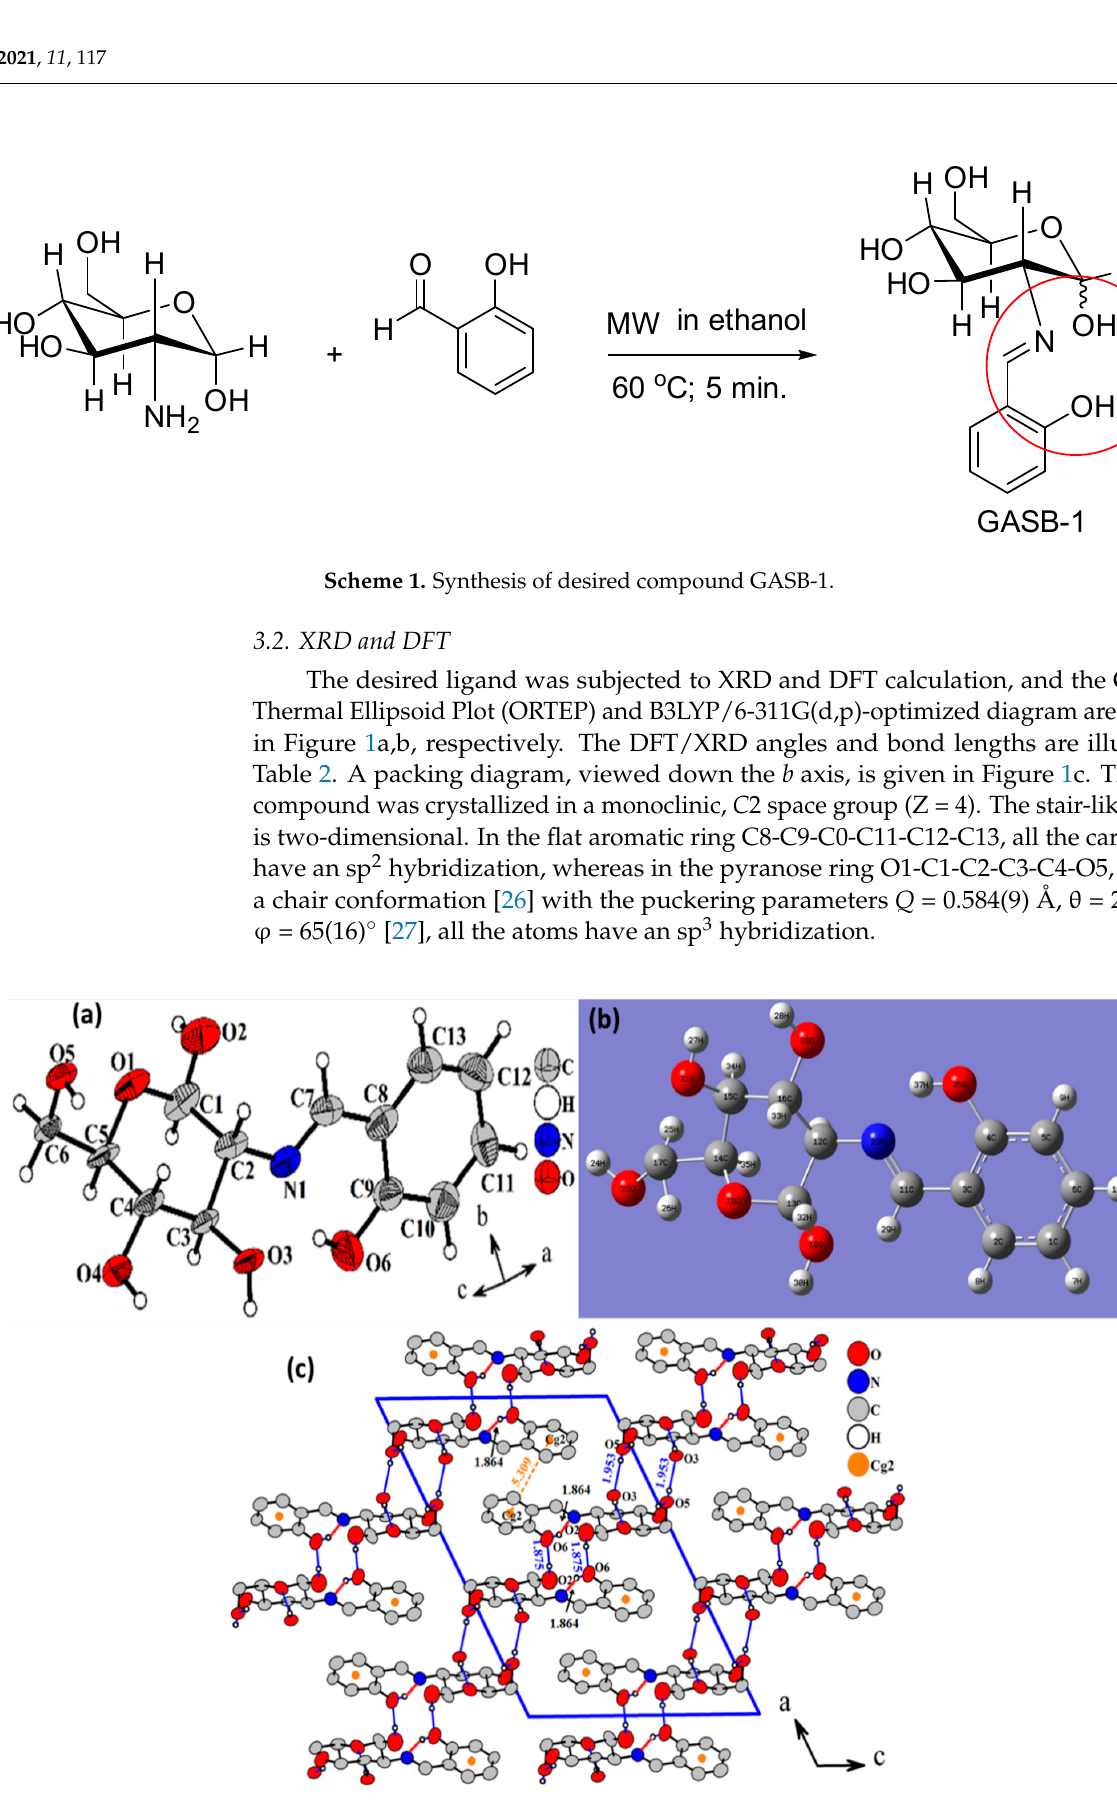
Figure 1. ( a ) ORTEP, ( b ) B3LYP/6-311G(d,p), and ( c ) packing diagrams viewed down the b axis.